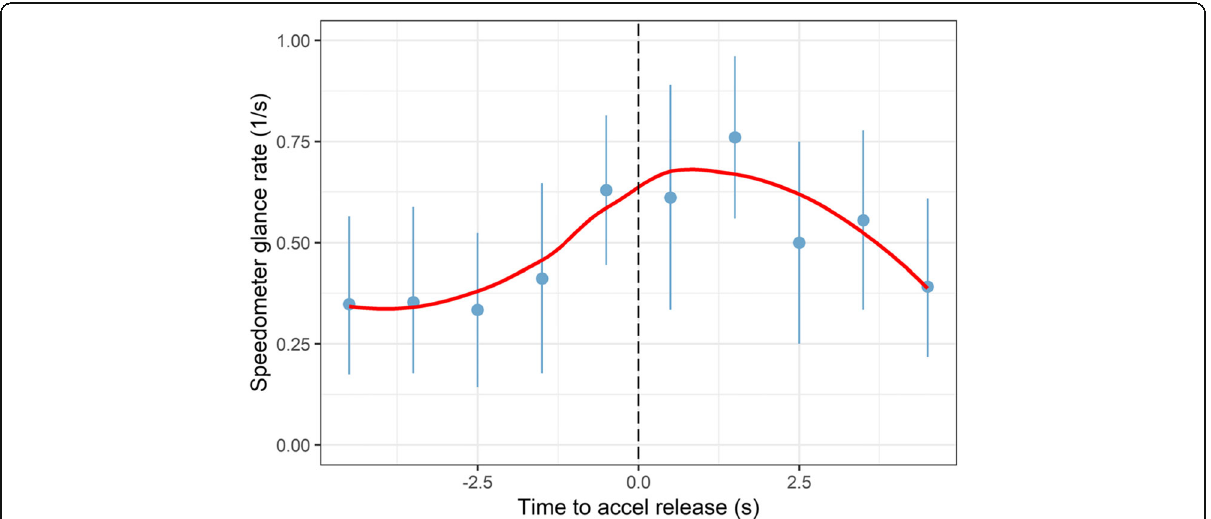
Fig. 10 Speedometer glance rate relative to the accelerator releases 0 – 3 after a warning. Mean and 95% CI shown, with loess smoothed solid red